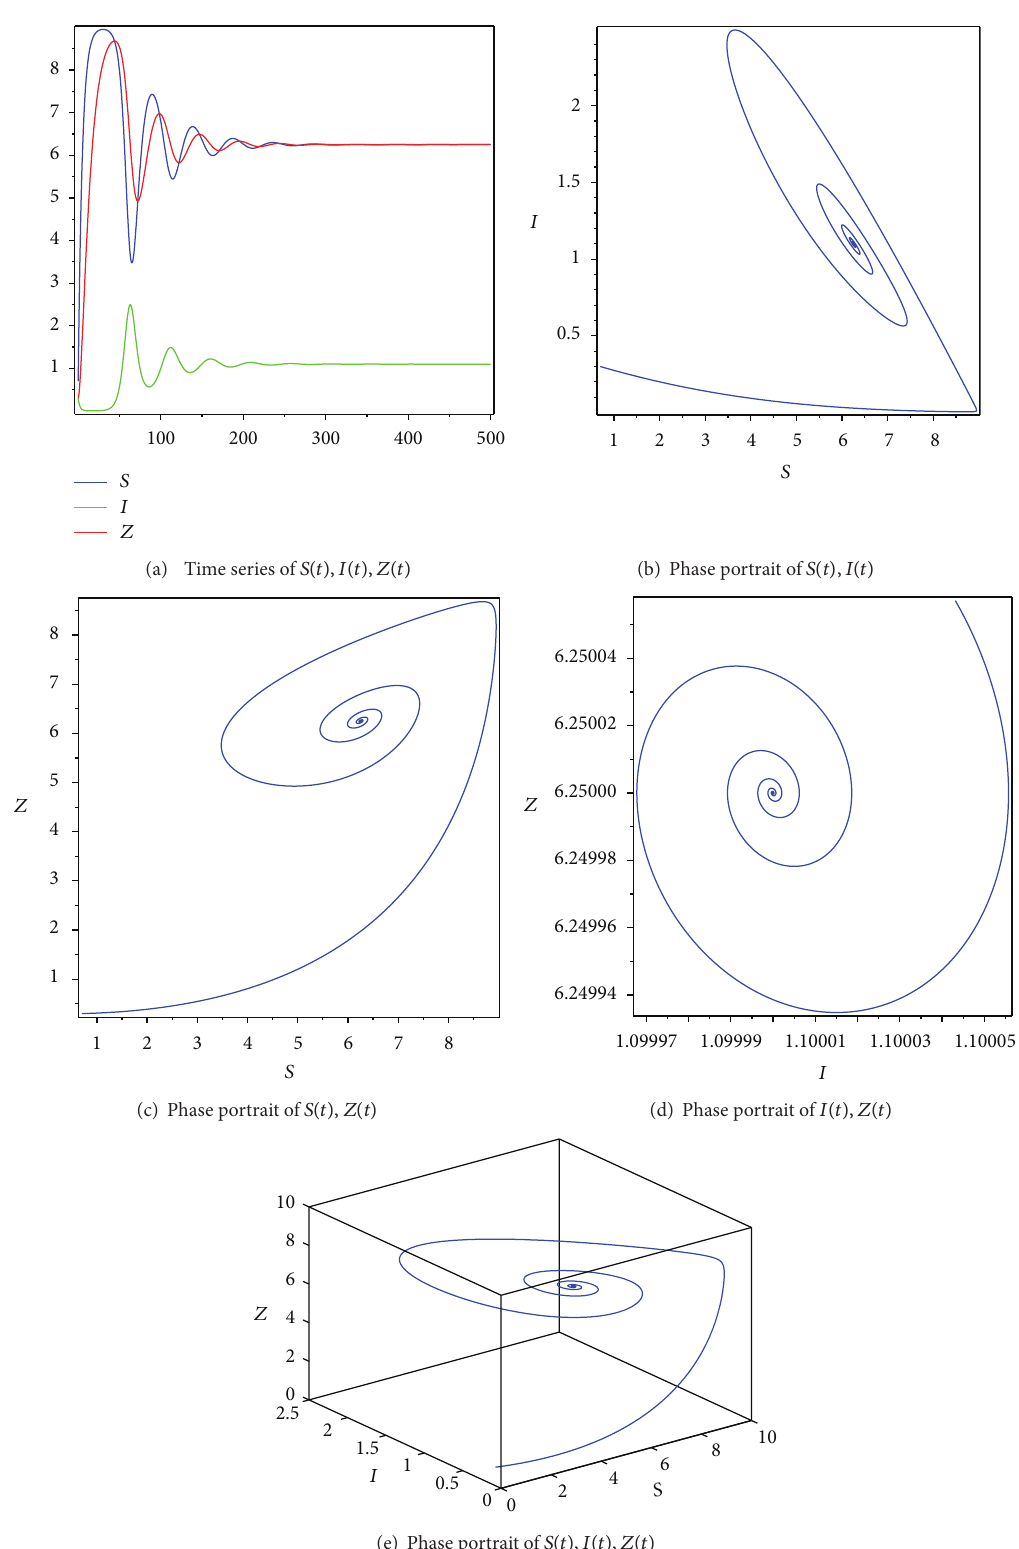
Figure 2: Illustration of basic behavior of system (7) on the threshold values 𝑅 = 1.44 > 1 , where Λ = 1.8, 𝜇 = 0.2, 𝛽 = 0.08, 𝑟 = 0.3, 𝑎 = 0.1 , the initial value is (𝑆 0 ,𝐼 0 ,𝑍 0 ) = (0.7, 0.3, 0.3) , and 𝐸 ∗ = (6.25, 1.1, 6.25)